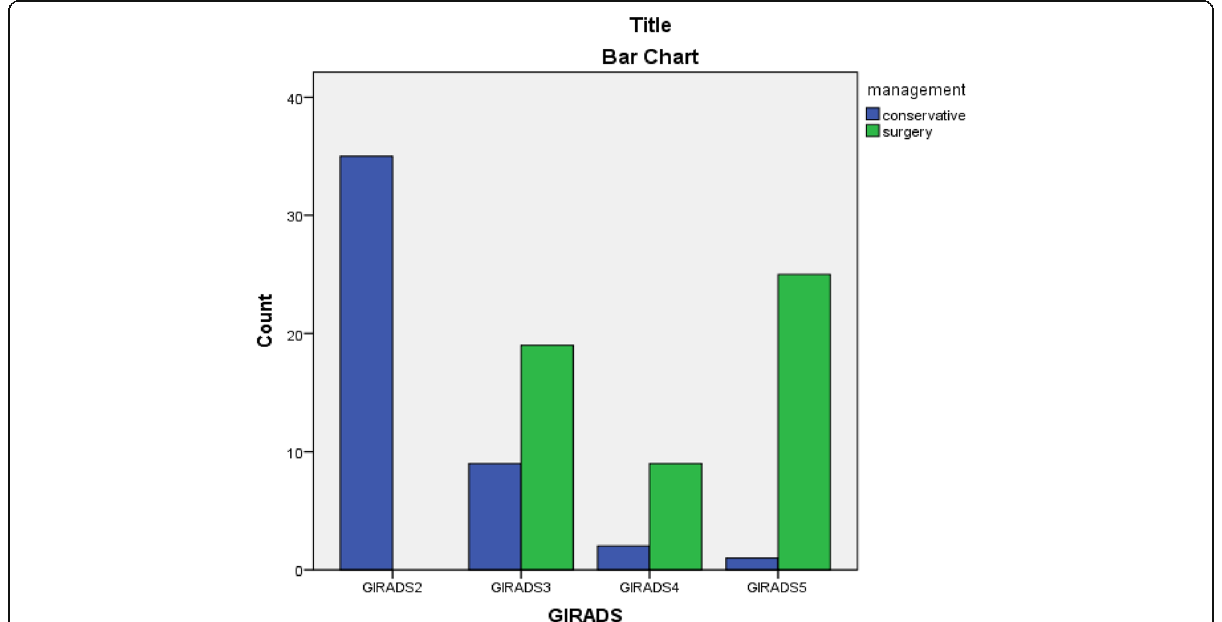
Fig. 6 Management of the adnexal lesions guided by GI-RADS classification